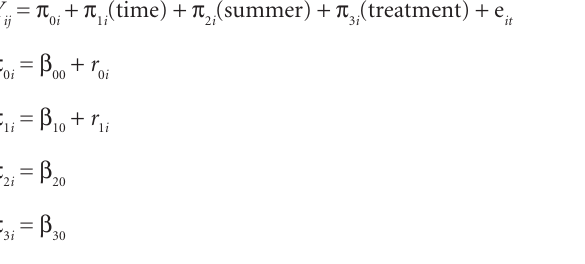
Table 4 | Predicted scores, standard errors, and 95% confidence intervals for the predicted scores. Time No